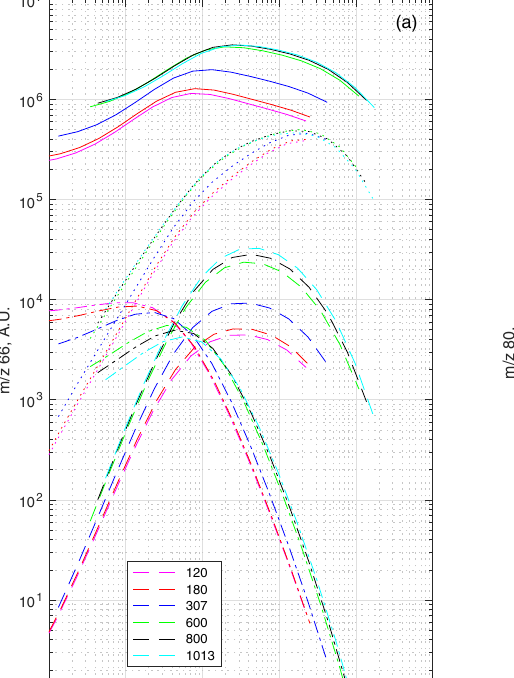
Figure 12. (a) Predicted ion cluster concentrations for species having m/z equal to 66: O − ( H 2 O ) dotted lines and 18 O of O − lines, O − 3 (b) Predicted ion cluster concentrations for species having m/z equal to 80: O − ( H 2 O ) dash-dot lines, for six sample pressures (hPa) indicated by color as given in the legend. See text for sample air flow rate and and NO − 3 composition and reagent gas composition used in the